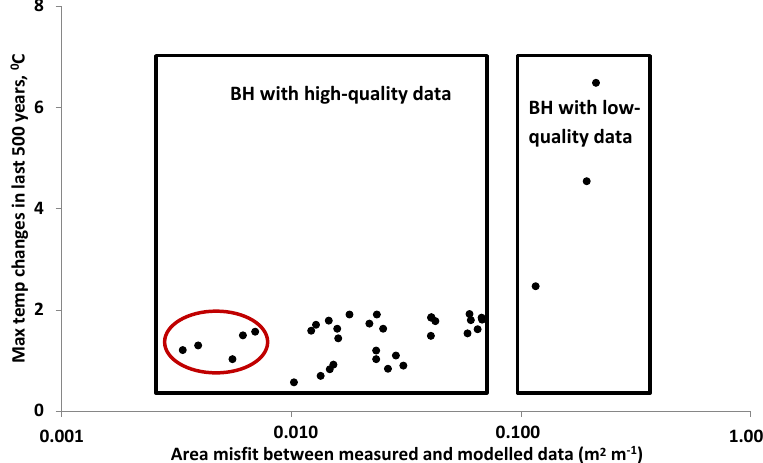
Figure 5. GTC with an area misfit between measured and modelled data.